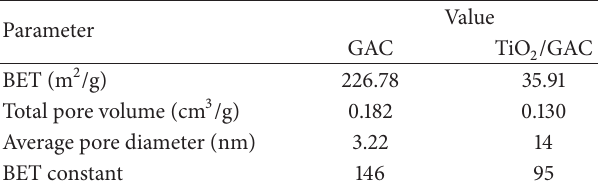
Table 1: Characteristics of GAC and the TiO 2 /GAC composite.